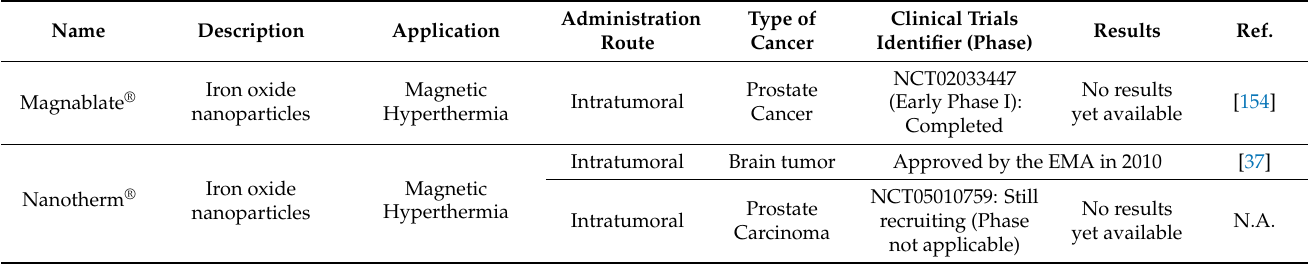
Table 5. Summary of clinical trials comprising metallic-polymer nanoconjugates/nanohybrids (N.A.—not